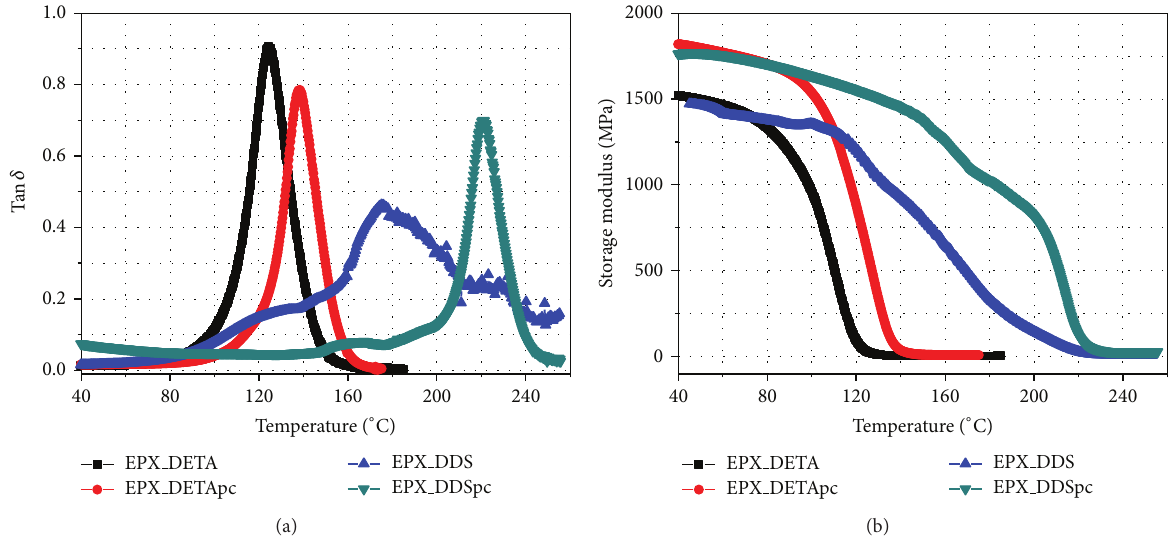
Figure 2: (a) Tan 𝛿 and storage modulus; (b) Tan 𝛿 as a function of the temperature for DGEBA/DDS and DGEBA/DETA epoxy system.